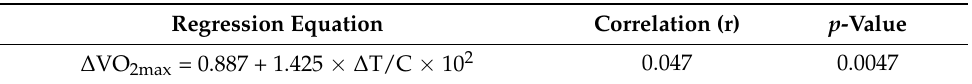
Table 7. Linear regression describing the relationships between pre–post changes ( ∆ ) in VO 2max T/C × 10 2 values in the experimental group.